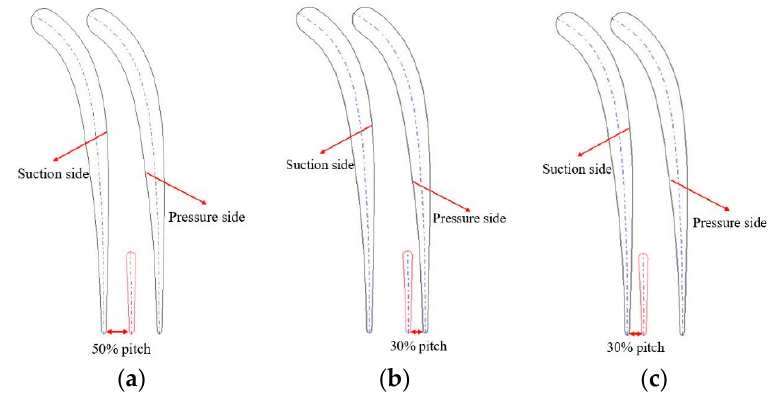
Figure 4. Splitter structures for the lowest solidity case: ( a ) normal; ( b ) ps offset; ( c ) ss offset.